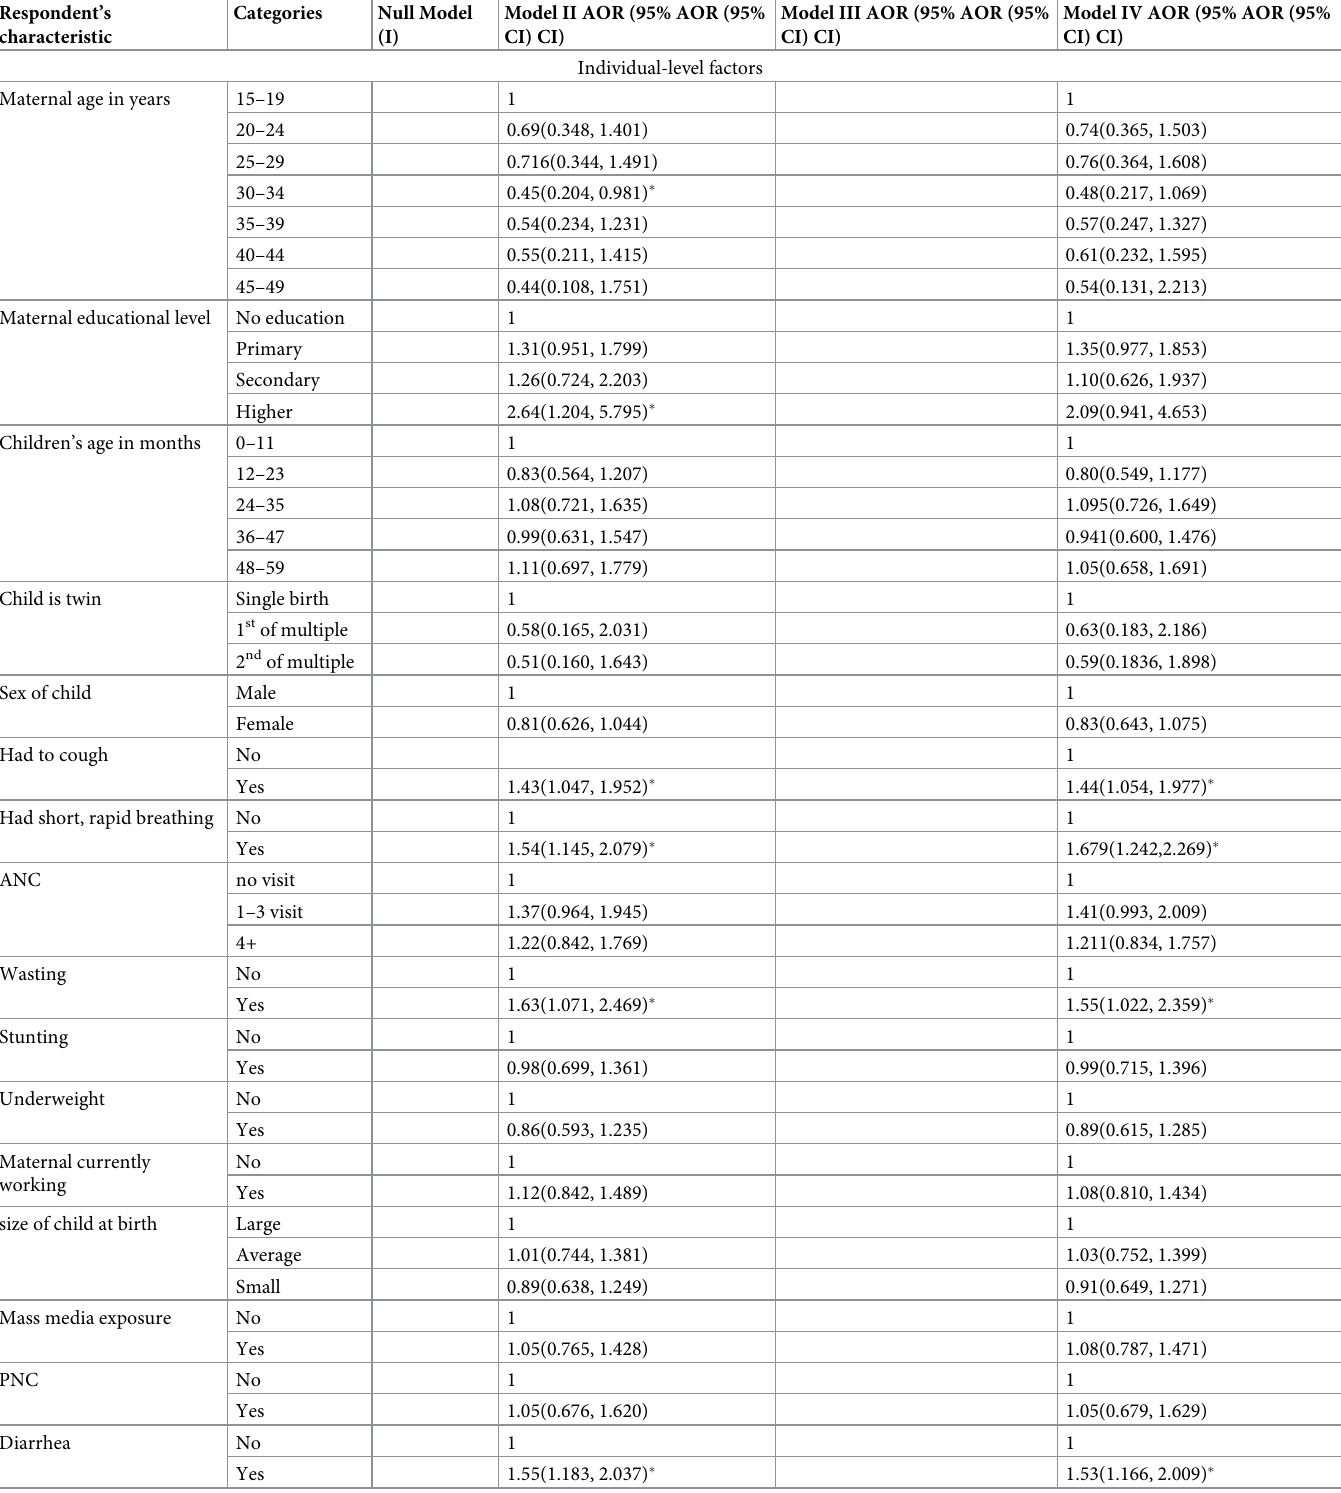
Table 2. Multilevel analysis of factors associated with treatment-seeking behaviour among caregivers with febrile children in Ethiopia,